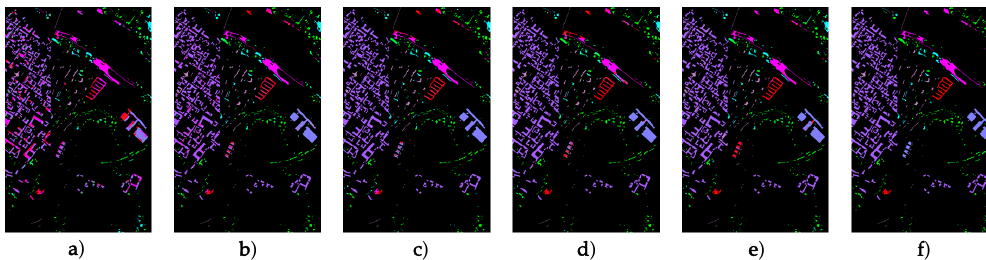
Figure 6. The classification maps of different methods for Pavia University → Pavia Center dataset. (a) Yang et al. method. (b) Mei et al. method. (c) Wang et al. +FT method. (d) First-Stage + FT method. (e) TDDA method. (f) Original map.